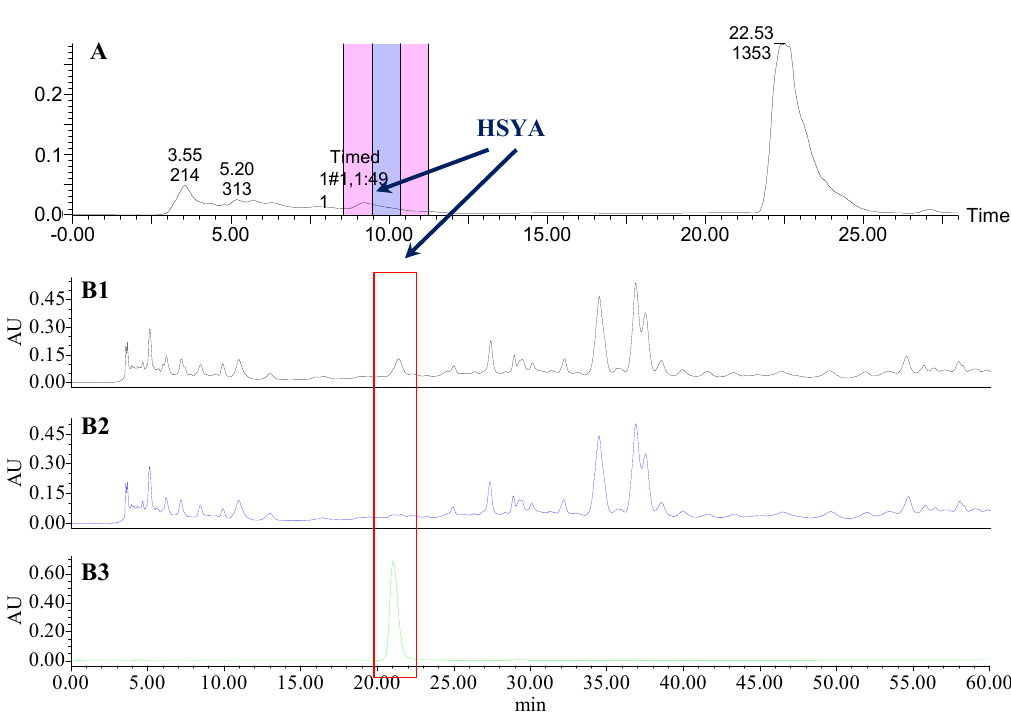
Figure 9. The preparative and analytical chromatograms of the depletion of HSYA from CF-GL. ( A ) preparative chromatogram at 270 nm; ( B1 ) analytical chromatogram of CF-GL at 270 nm; ( B2 ) analytical chromatogram of CF-GL-A at 270 nm; ( B3 ) analytical chromatogram of HSYA depleted from CF-GL at 270 nm.